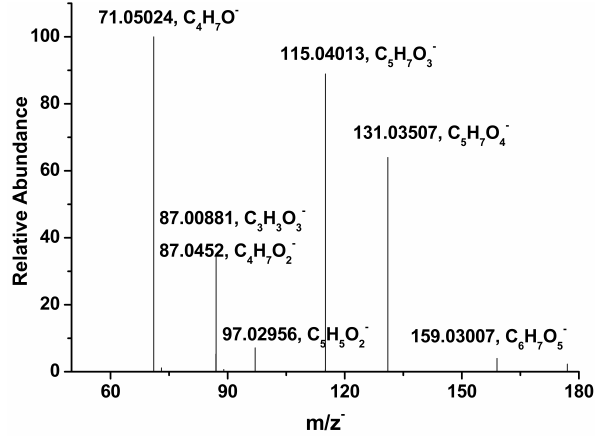
Fig. 5. FT-ICR MS-MS spectra of m/z − 177 from 1mM methylgly- oxal+OH radical experiment (76min reaction